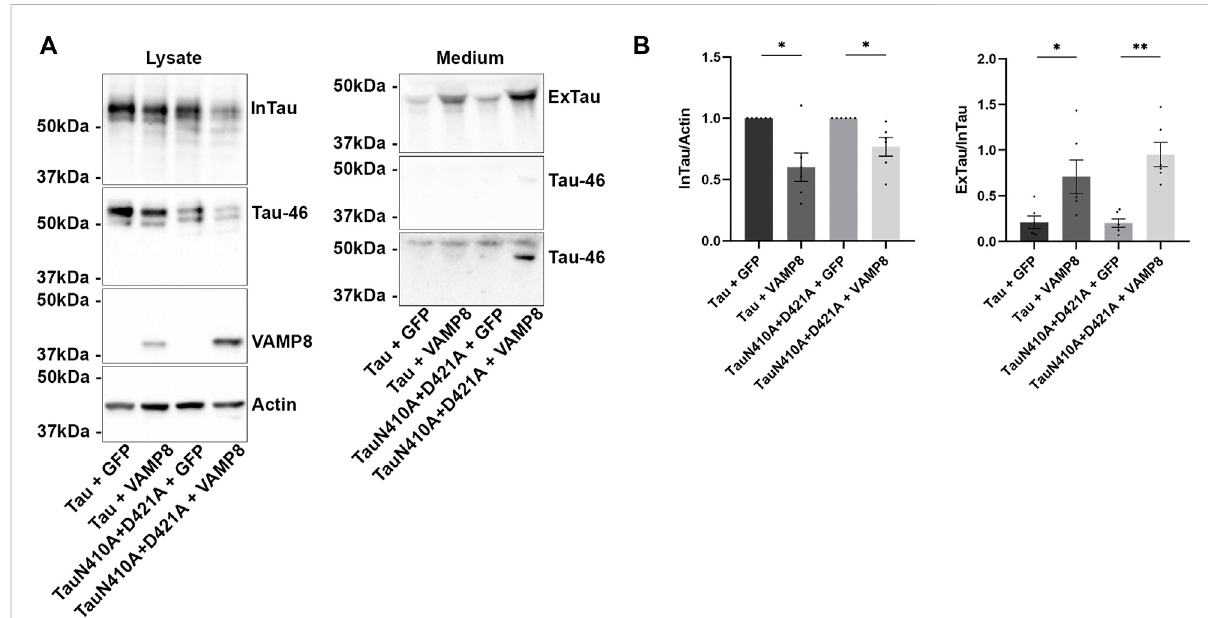
FIGURE 5 The asparagine N410 affects the cleavage of secreted Tau upon VAMP8 overexpression. N2a cells were transfected either with Flag-Tau and GFP-empty, Flag-Tau and GFP-VAMP8, TauN410A+D421A and GFP-empty or TauN410A+D421A and GFP-VAMP8 plasmids for 48 h. (A) Representative Western blot with A0024 of the cell lysate and the medium revealing that the overexpression of VAMP8 decreased intracellular Tau (InTau) and increased extracellular Tau (ExTau) for both Tau mutant and wild-type. A signal was detected with the anti-Tau antibody Tau46 in boththecelllysateandmediumindicatingthepresenceofuncleavedTauattheC-terminal.Ashortandalongexposuretimesarepresentedtoshow that the Tau46 antibody signal was not detected when wild-type Tau was expressed. (B) Densitometry analysis of A0024 signal of InTau. Actin was used as a loading reference. Densitometry analysis of A0024 signal of ExTau. Normalized Tau secretion corresponds to the ratio ExTau/InTau. InTau was normalized with the actin signal. N = 6. Data represent scatter plot and mean±SEM. * p < 0.05. ** p <